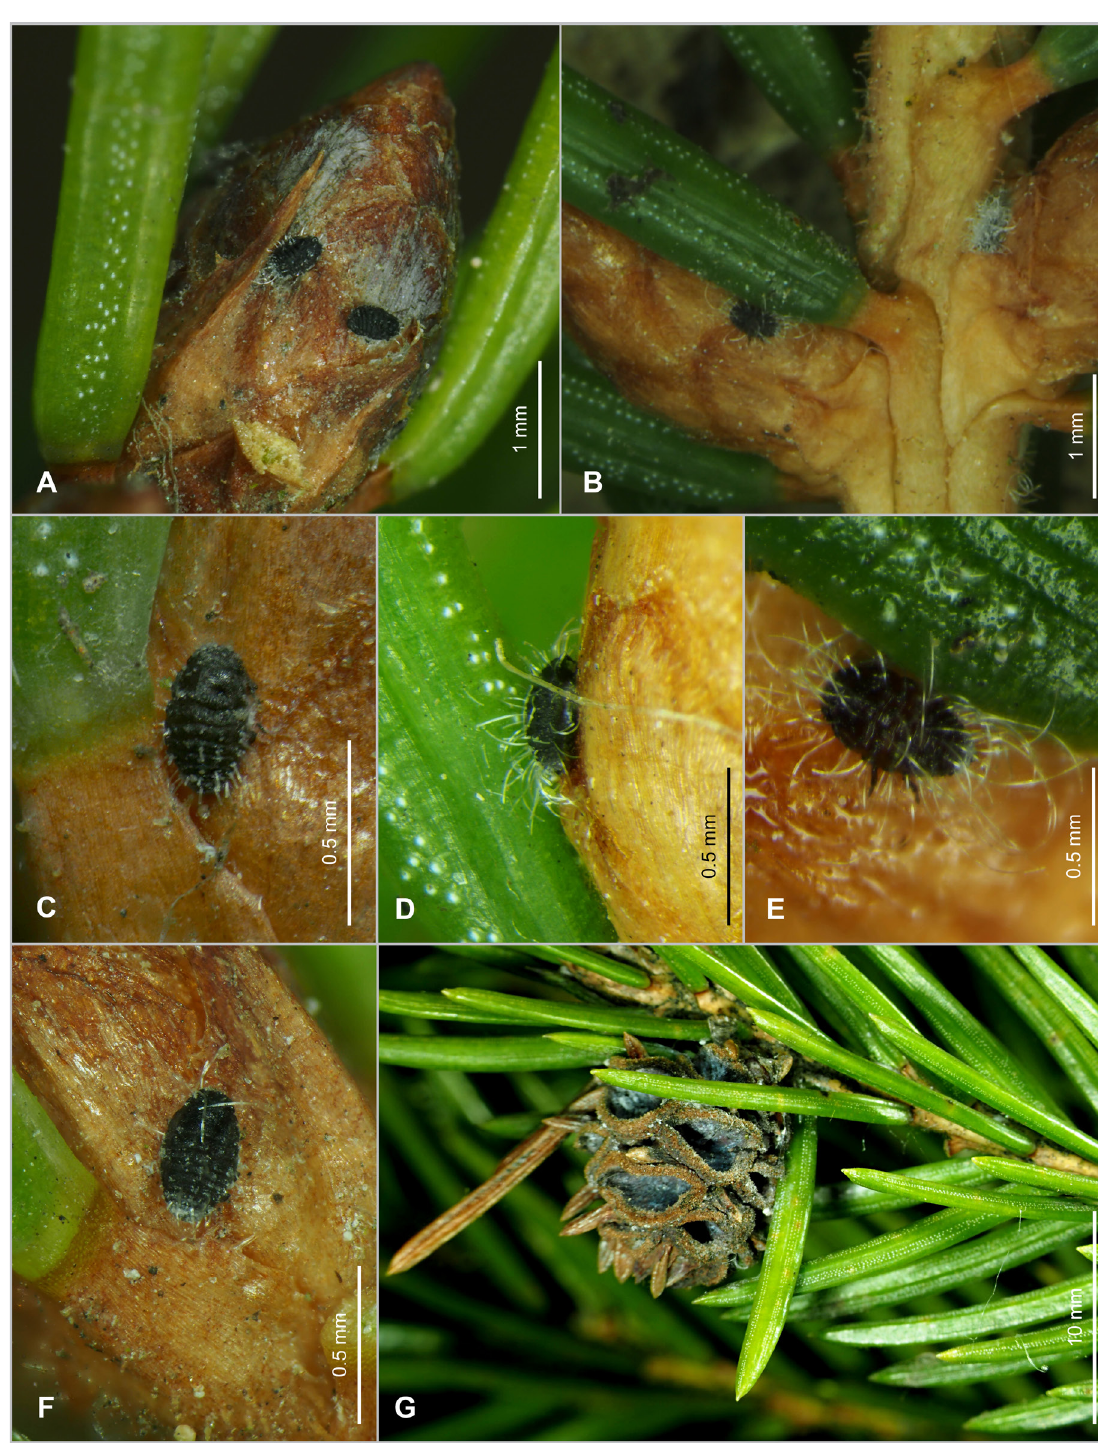
Fig. 12. Adelges (Adelges) tardus (Dreyfus, 1888). A–F . Hibernating pseudofundatrix nymphs on buds of Picea abies . Note the sparse, long, more or less straight wax filaments (most of them worn off, except in D–E). Often together with nymphs of A. (Sacciphantes) abietis (Linnaeus, 1758), whose wax filaments are dense, flattened and strongly curled (the specimen to the right in B). The nymphs usually hibernate on the surface of the bud, whereas those of A. abietis prefer bud bases and axils. G . Hibernating nymphs, which are easiest to find in the vicinity of the previous summer’s